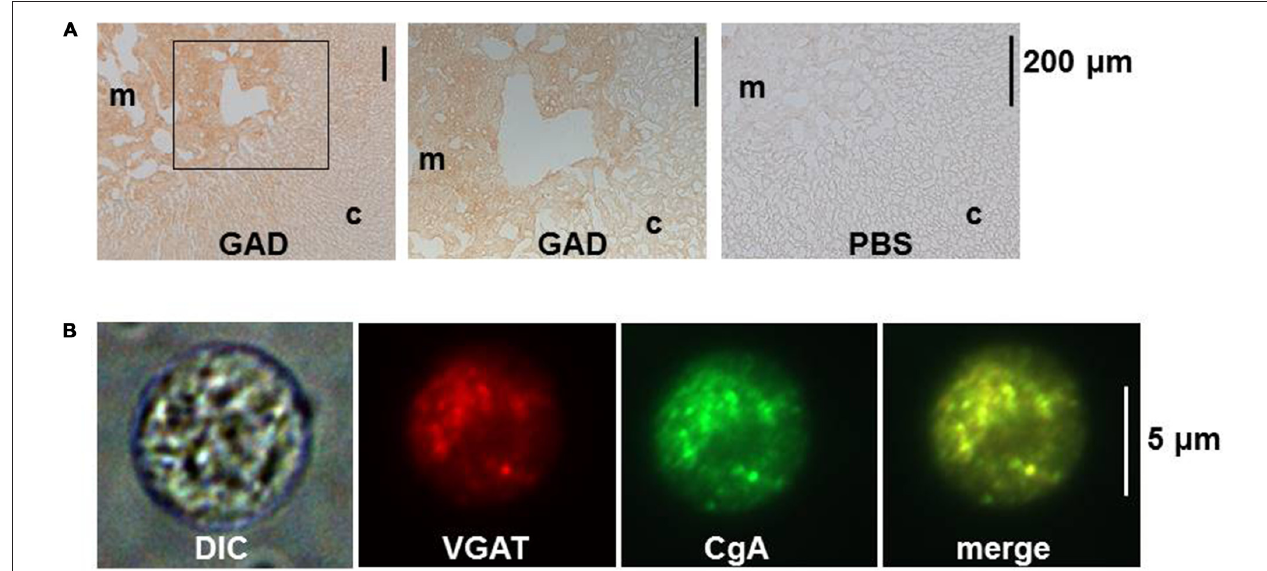
FIGURE 1 | Immunostaining for glutamic acid decarboxylase (GAD) and vesicular GABA transporter (VGAT) in rat adrenal medullary chromaffin cells. (A) Immunohistochemistry for GAD in rat adrenal gland. Sections were incubated overnight in PBS with (GAD) or without (PBS) rabbit anti-GAD antibody (Ab). The bound Ab was detected with the indirect immunoperoxidase method. The middle panel represents an enlargement of the area indicated by the square in the left panel. (B) Immunocytochemistry for VGAT in a dissociated rat adrenal medullary cell. The adrenal medulla was treated with collagenase and then cells were mechanically dissociated with needles. The cells were treated overnight with rabbit anti-VGAT Ab and goat anti-chromogranin A (CgA) Ab and then with secondary Abs conjugated with Alexa 488 and Alexa 546. Images from left to right represent differential interference contrast (DIC), rhodamine-like, FITC-like, and merge of the second and the third. (A,B) Are reproduced from Matsuoka et al. (2008).